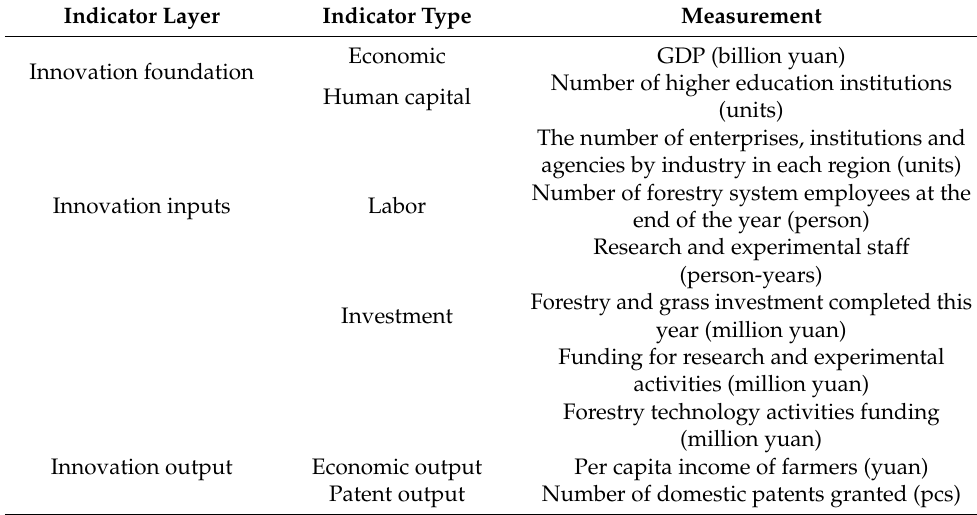
Table 1. Evaluation index system of forestry technology innovation